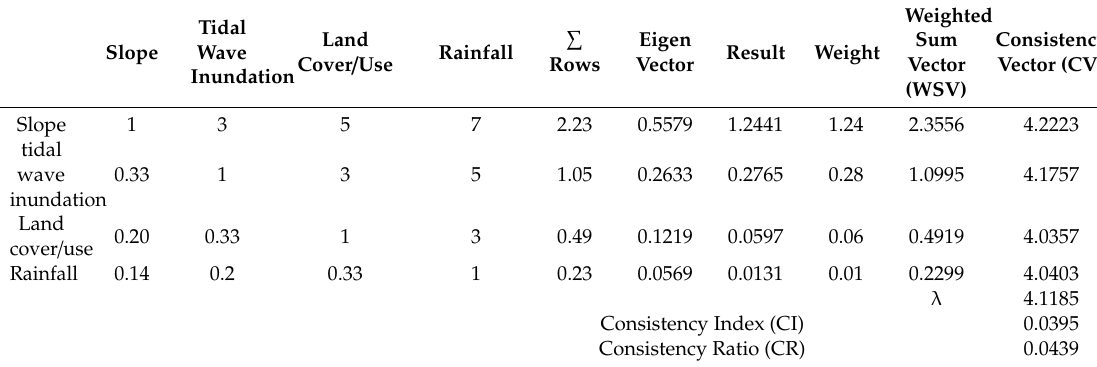
Table 6. AHP judgement matrix of the coastal flood-prone areas by combined drivers (CFC)-a ff ecting parameters and consistency ratio